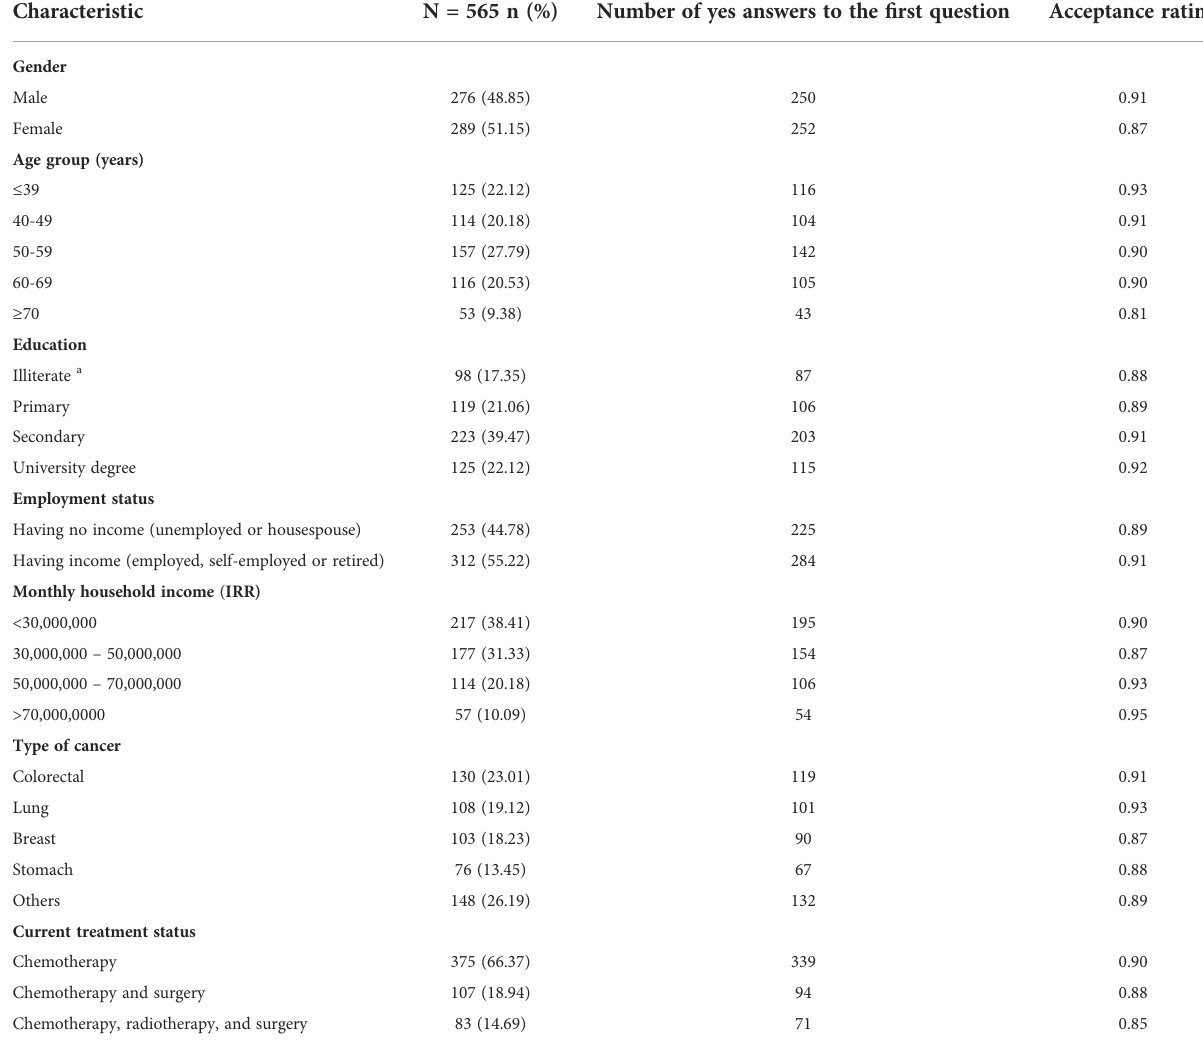
TABLE 4 Acceptance rate to the fi rst question among signi fi cant variables.